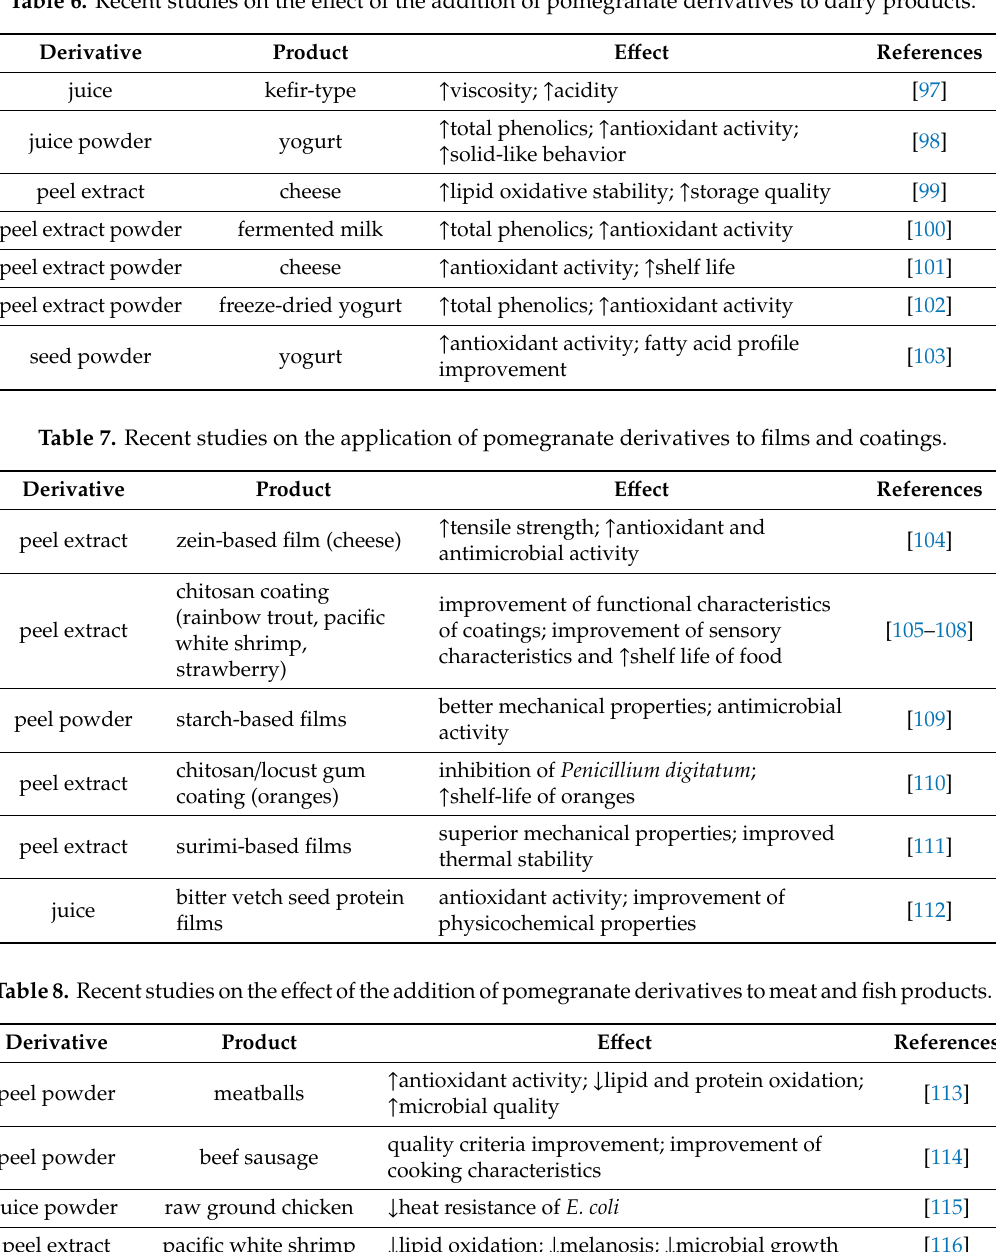
Table 6. Recent studies on the e ff ect of the addition of pomegranate derivatives to dairy products.